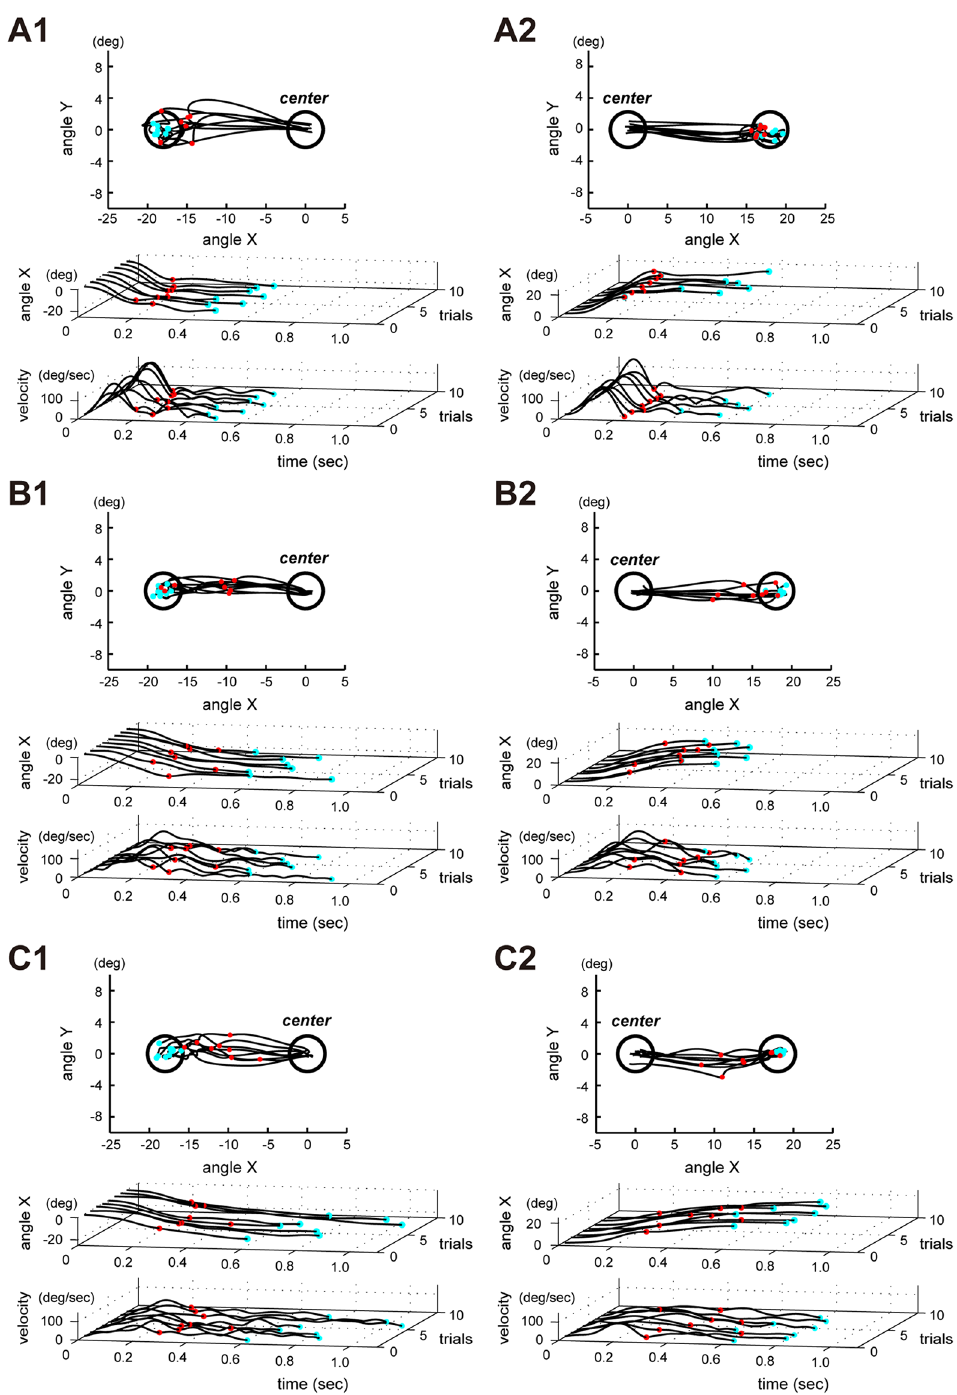
Fig 2. A typical example of step-tracking movements in the three age groups. (A1) An exampleof the wrist flexion movement in youngsubjects. The black lines in the inset represent the movement trajectories, whilethose in the top and bottom traces show the correspondingX-axis componentof wrist joint angle (shortly, angle X) and the corresponding tangentialvelocity profiles, respectively.Also, the red circles on the trajectories, the angle X and the velocity profiles show the end of the primary submovements, while the cyan points represent the final end-pointsfor the step-tracking movements. (A2) An exampleof the wrist extension movement in young subjects. (B1) An exampleof the wrist flexionmovement in middle-age subjects. (B2) An exampleof the wrist extensionmovement in middle-agesubjects. (C1) An exampleof the wrist flexion movement in elderly subjects. (C2) An exampleof the wrist extensionmovement in elderly subjects.